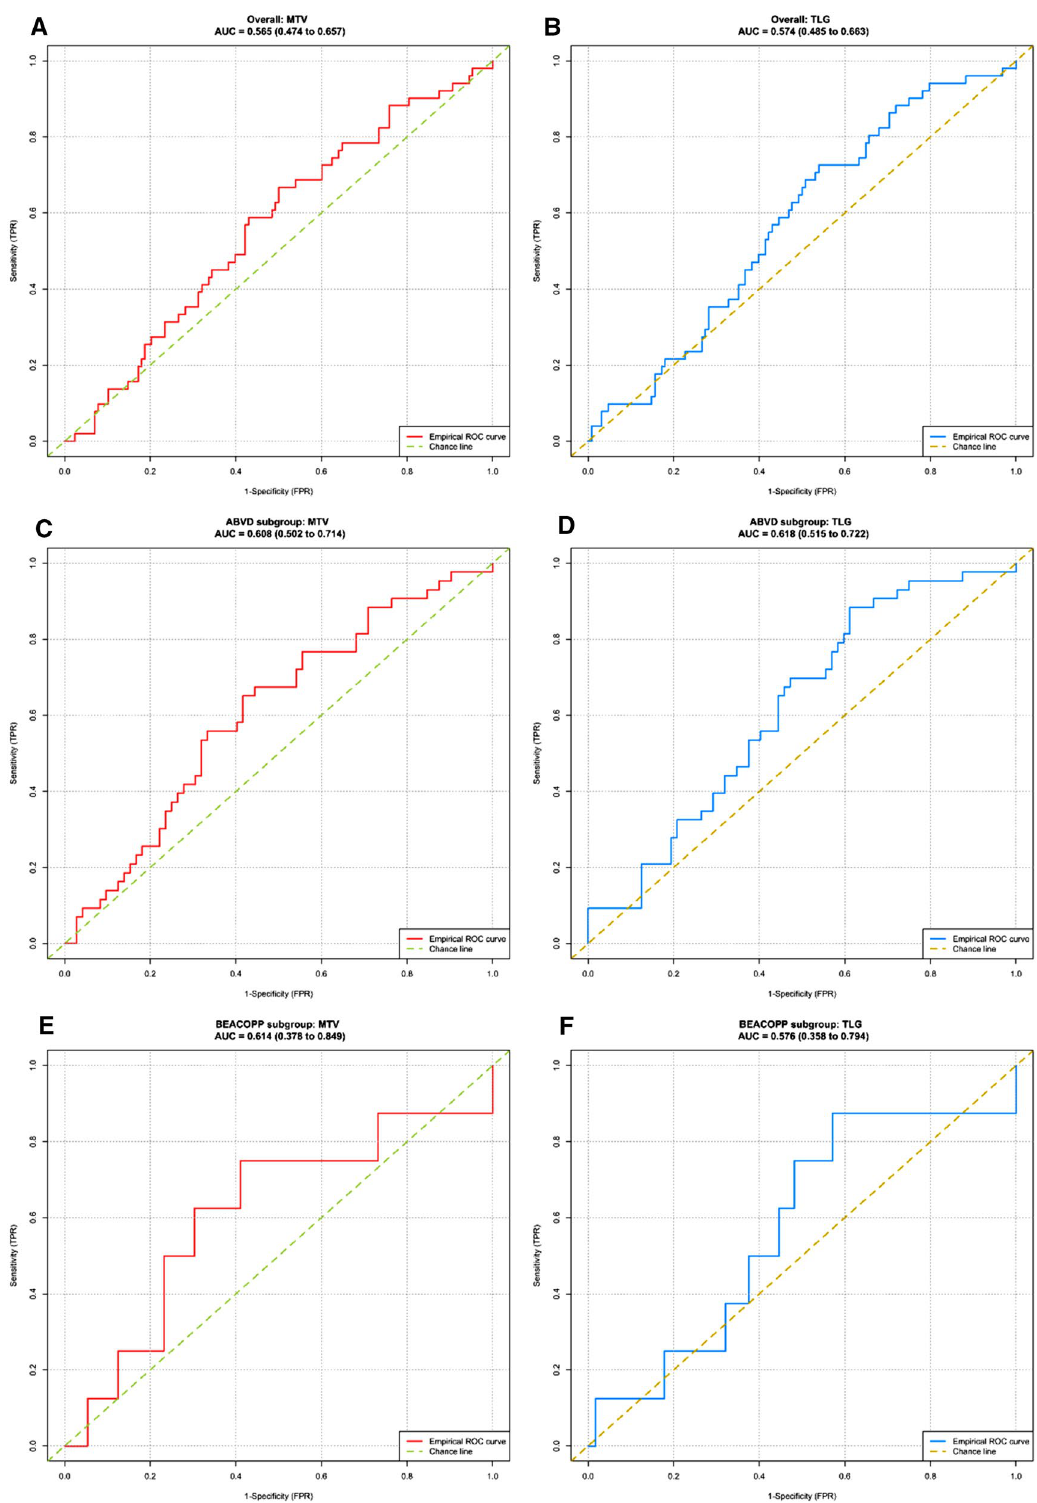
Figure 1. Receiver operating characteristics (ROC) curves analysing the prognostic performance of total metabolic tumour volume (TMTV) and TLG on 5-year progression-free